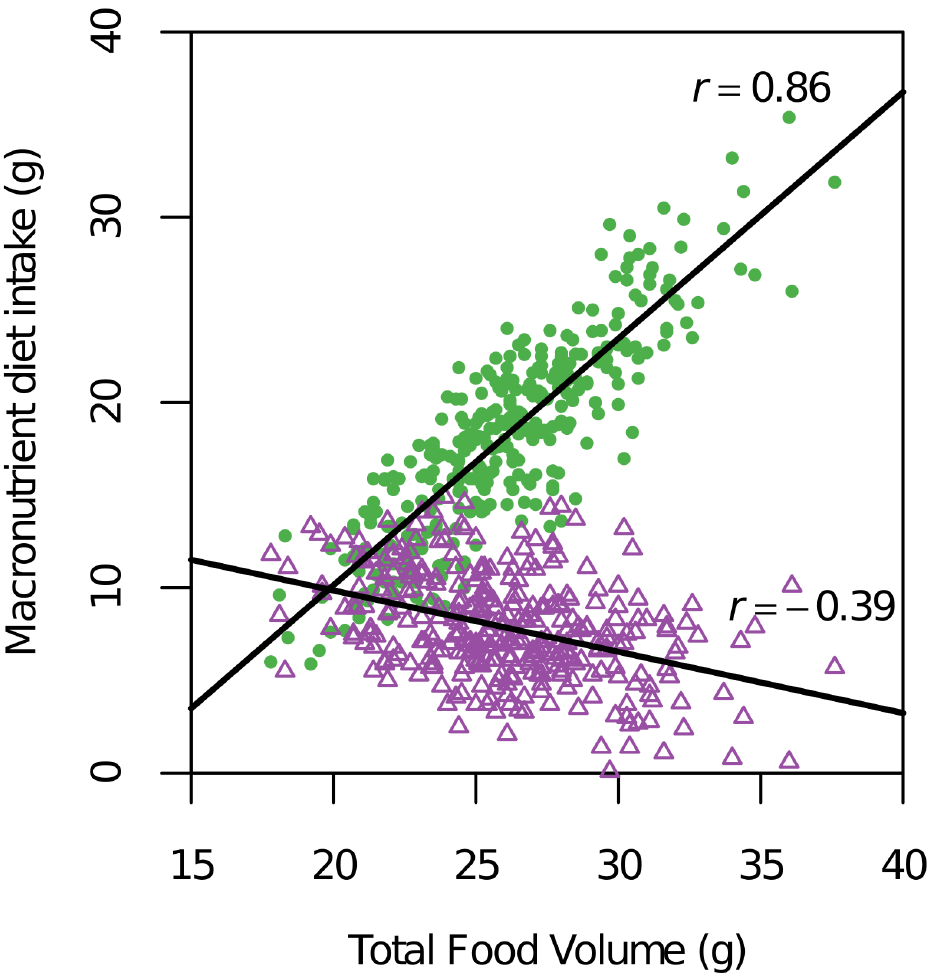
Figure 4. Preferential carbohydrate intake was positively correlated with total food volume in recombinant subcongenic-derived F 2 mice. Legend: The macronutrient diet selection phenotype of preferential carbohydrate- versus fat-specific intake, unique to this genetic model, is illustrated. The total volume of food consumed in g was strongly and positively correlated with carbohydrate/protein (C/P) intake ( r =0.86, P , 0.0001), but inversely correlated with fat/protein (F/P) intake ( r = 2 0.39, P , .0001) in this macronutrient diet choice paradigm.